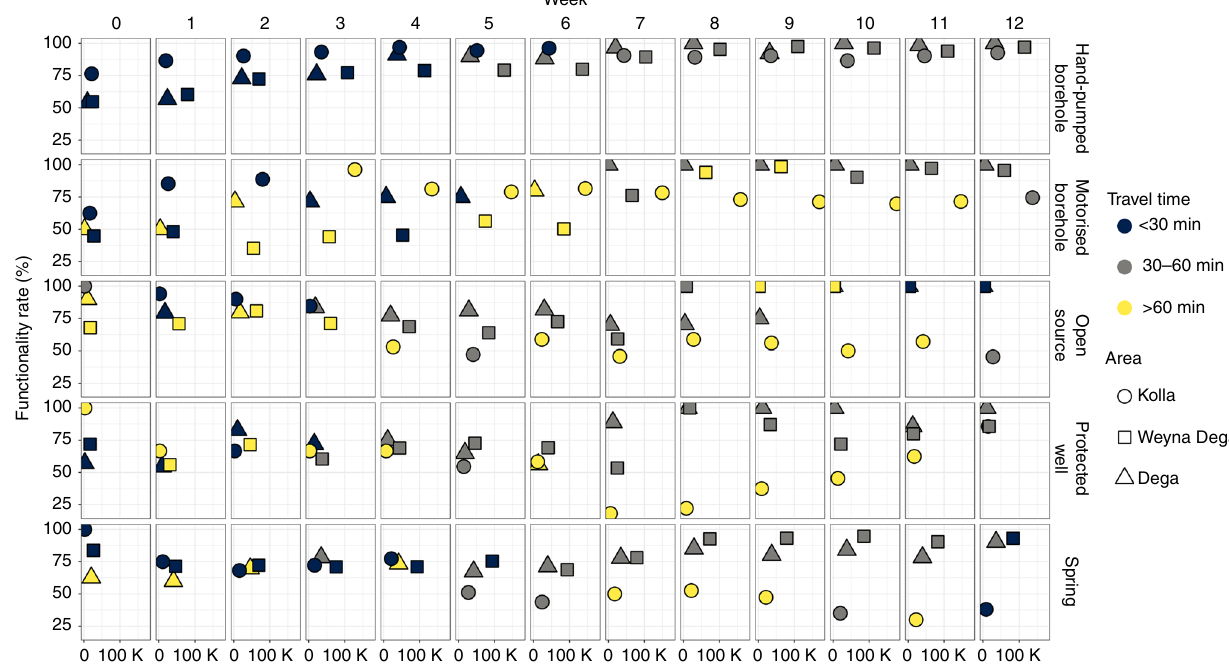
Fig. 7 Summary of functionality, user numbers and travel times by water source type and altitude zone. The position of the points in the individual panels represent the functionality and overall user numbers for each water source type (a total of ~830,000 people relied on the water sources included in the monitoring programme), colours represent modal travel times for water collection and shapes represent altitude areas. The evolution of the performance of each water source type (in terms of functionality, access and usage) reveals fi ve key points. (1). Hand-pumped boreholes experienced the most consistent overall increases in functionality in all areas and most users travelled for <60 min for water collection (in the fi rst 6 weeks <30 min). (2) Motorised borehole performance was more variable with very low functionality in the Weyna Dega (<50%) and many users having to travel for >60 min to access water throughout the intervention period. (3) In general hand-pumped and motorised boreholes, which accessed deep groundwater (>30 m), were a very important water source for many people during the drought and provided water to ~400,000 people; hand-pumps provided for >100,000 people in the Weyna Dega. Motorised boreholes provided for ~150,000 people in the Kolla. (4) Springs performed reasonably well in the Weyna Dega and Dega areas providing water (travel times < 60 min) to ~100,000 people in the Weyna Dega. Springs were also an important and accessible form of water supply to Kolla communities early in the drought but experienced large declines in functionality from week 6 onwards. (5) Open sources and protected wells experienced large declines in functionality in the Kolla areas but increased functionality in the Weyna Dega and Dega towards the end of the drought period associated with local